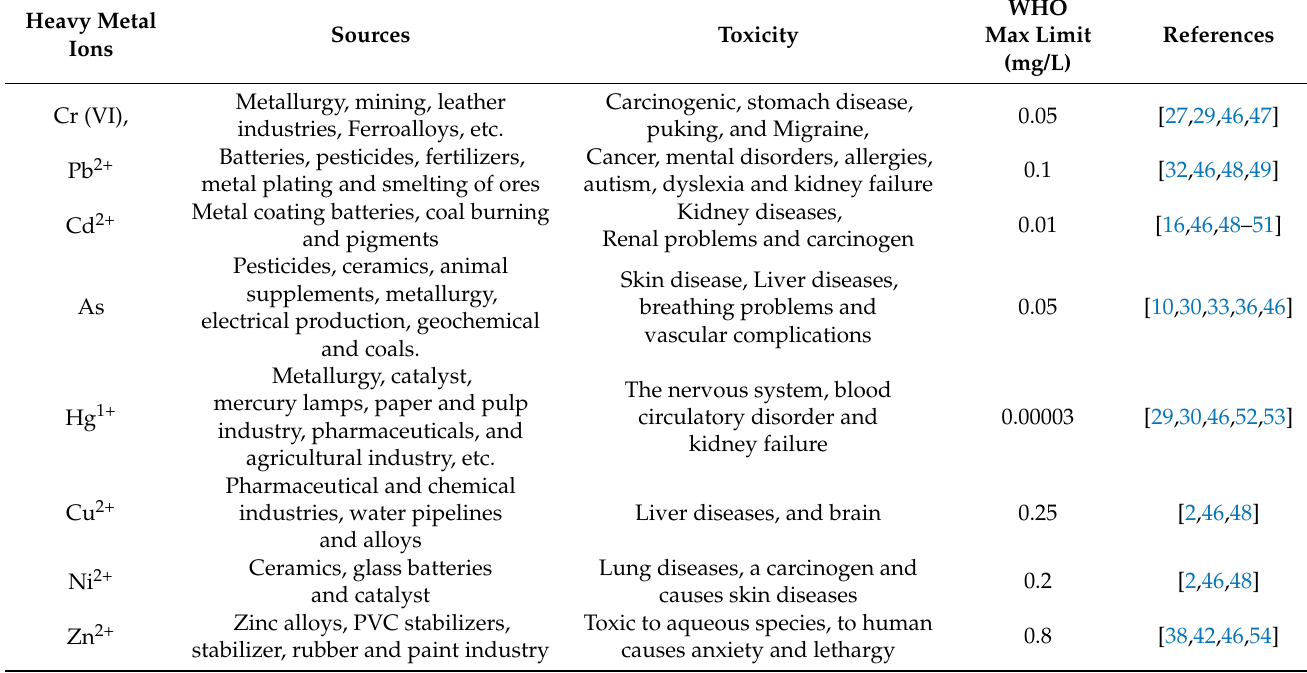
Table 1. The sources, toxicity and WHO permissible limit of heavy metal